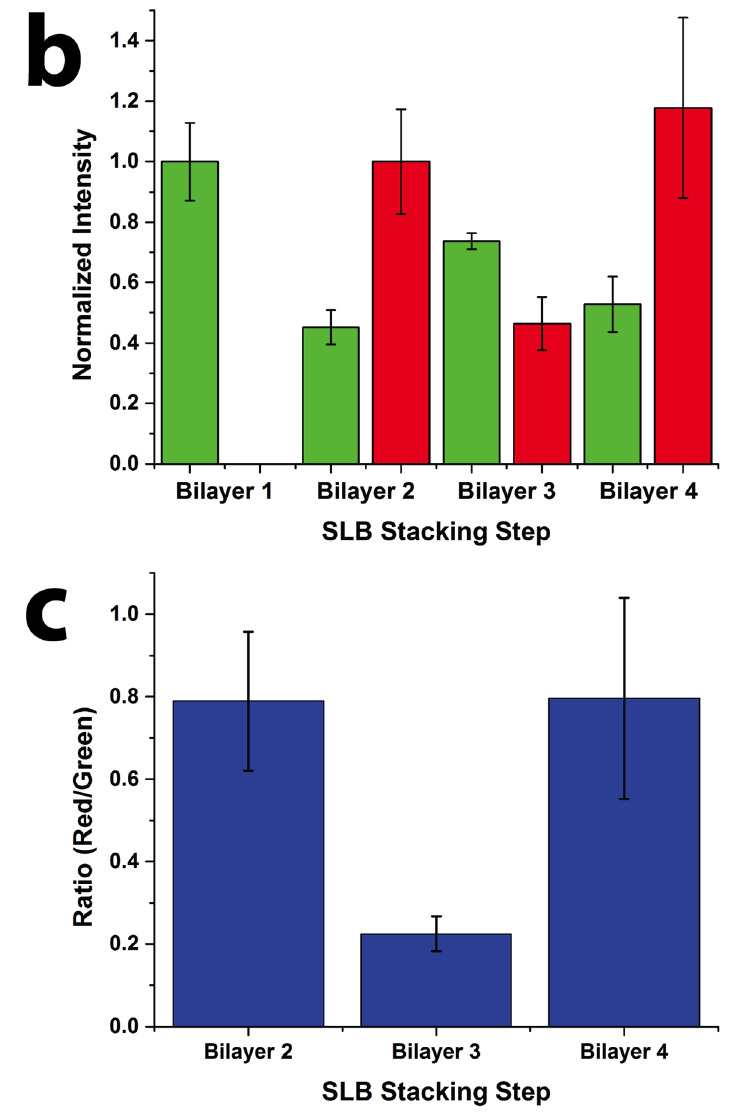
Figure 3. Quantitative fluorescence intensity analysis of stacked SLB formation. ( a ) Raw fluorescence intensity of green (DHPE-OG) and red (DHPE-LR) channels of the four-bilayer SLB patterns after each stacking step; ( b ) normalized intensity of each stacking step (green channel normalized to bilayer 1 and red channel normalized to bilayer 2 values); and ( c ) ratio of the raw intensities of red to green channels at each stacking